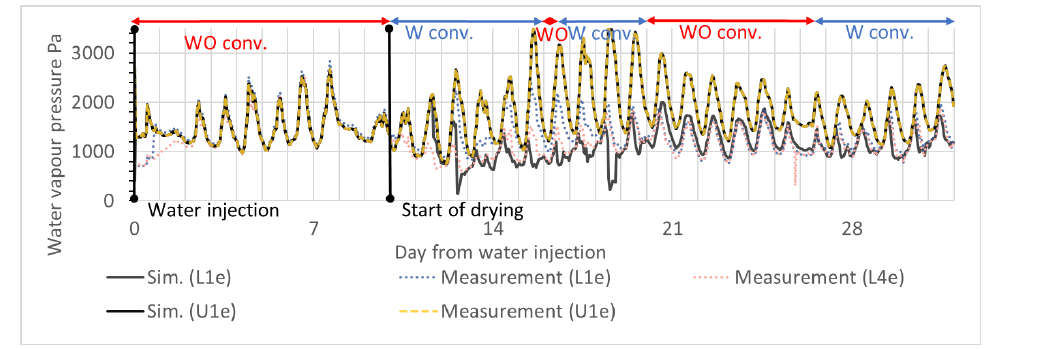
Figure 3. Modelled water vapour pressure at sensor positions compared to measured results (Figure 2). W conv. is for time range when lower section of the wall was ventilated and WO conv. when not.